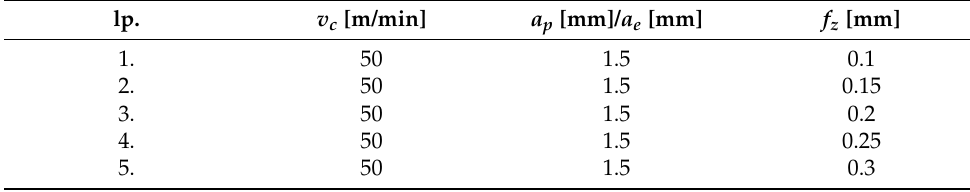
Figure 5. Scheme of the milling cutter measuring station in the x and y axes. In the first phase, the stiffness of the tool and workpiece system was determined. For this purpose, a known force ranging from 0 to 1000 N was applied to the tool and the workpiece. During the loading, the displacement was measured and then, using formula (6), the stiffness of the system was calculated. 𝑥𝑥̅ = Σ 𝐹𝐹 1 𝑎𝑎 1 + 𝐹𝐹 2 𝑎𝑎 2 + ⋯ 𝐹𝐹 𝑛𝑛 𝑎𝑎 𝑛𝑛 𝑛𝑛 ; 𝑛𝑛 ∈ 𝑁𝑁 (6) where: 𝑥𝑥̅ —average stifness [N/µm] F —applied force [N] a —linear displacement [µm] n —number of cases On this basis, the following average values of stiffness were obtained: x z = 2.367 [N/µm]